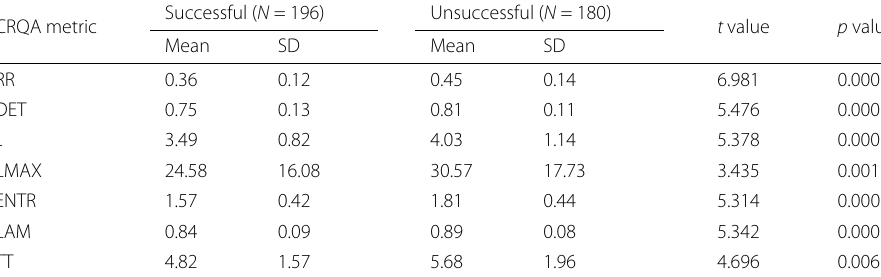
Table 2 T test CRQA results in the case-level analysis ( N = 376) CRQA